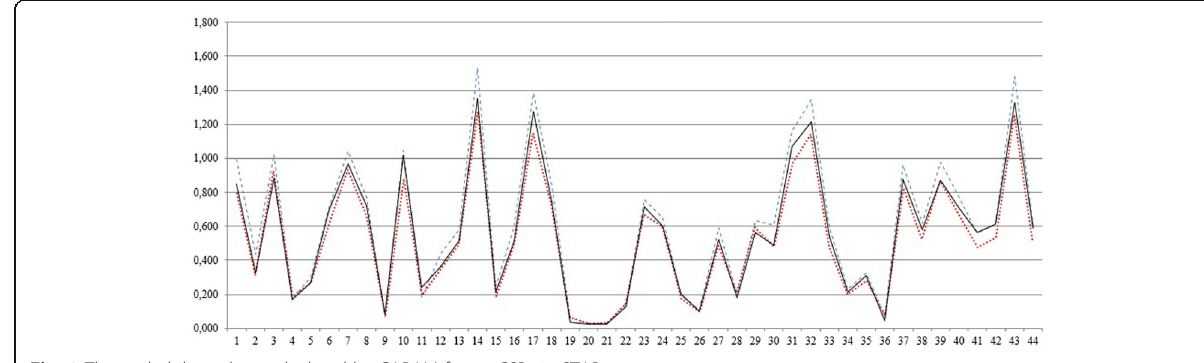
Fig. 9 The probability values calculated by CARAM for 44 CSPs in